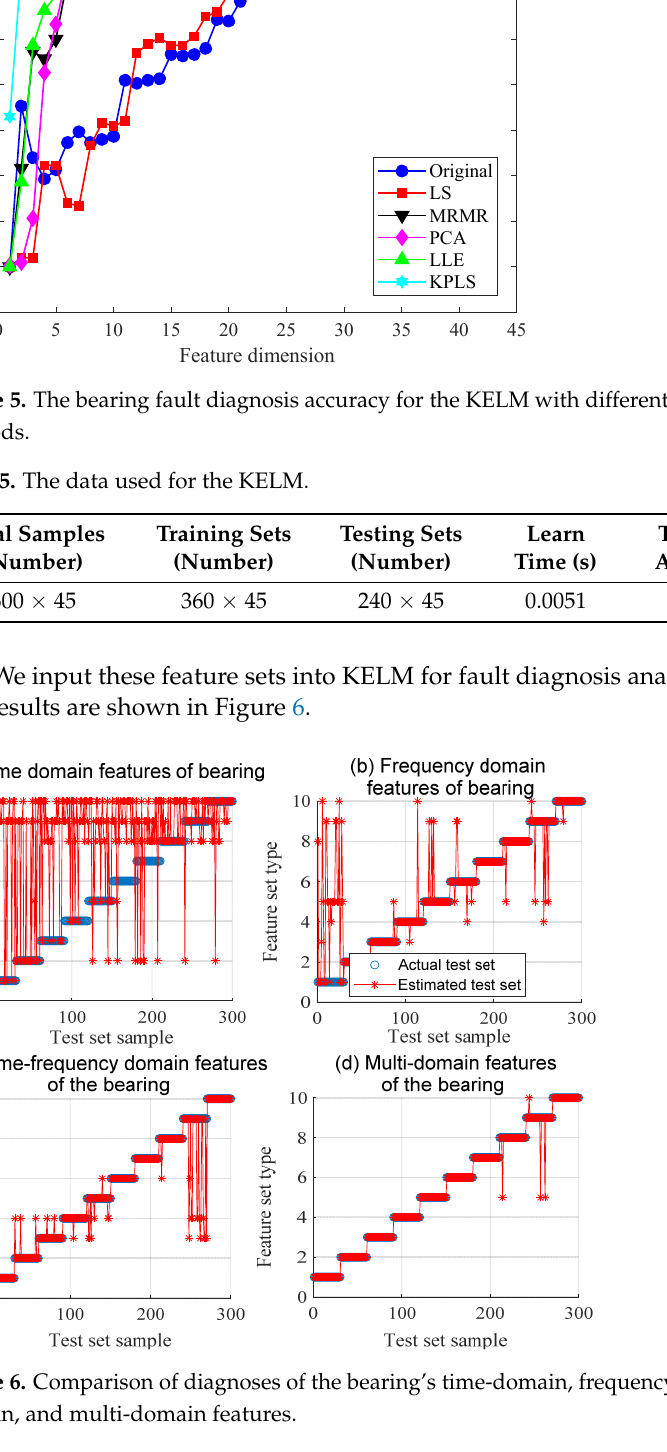
Figure 6. Comparison of diagnoses of the bearing’s time − domain, frequency − domain, time–fre- quency − domain, and multi − domain features.